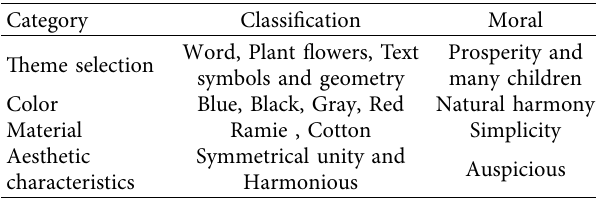
Table 2: Decorative art features of Hakka traditional costumes.